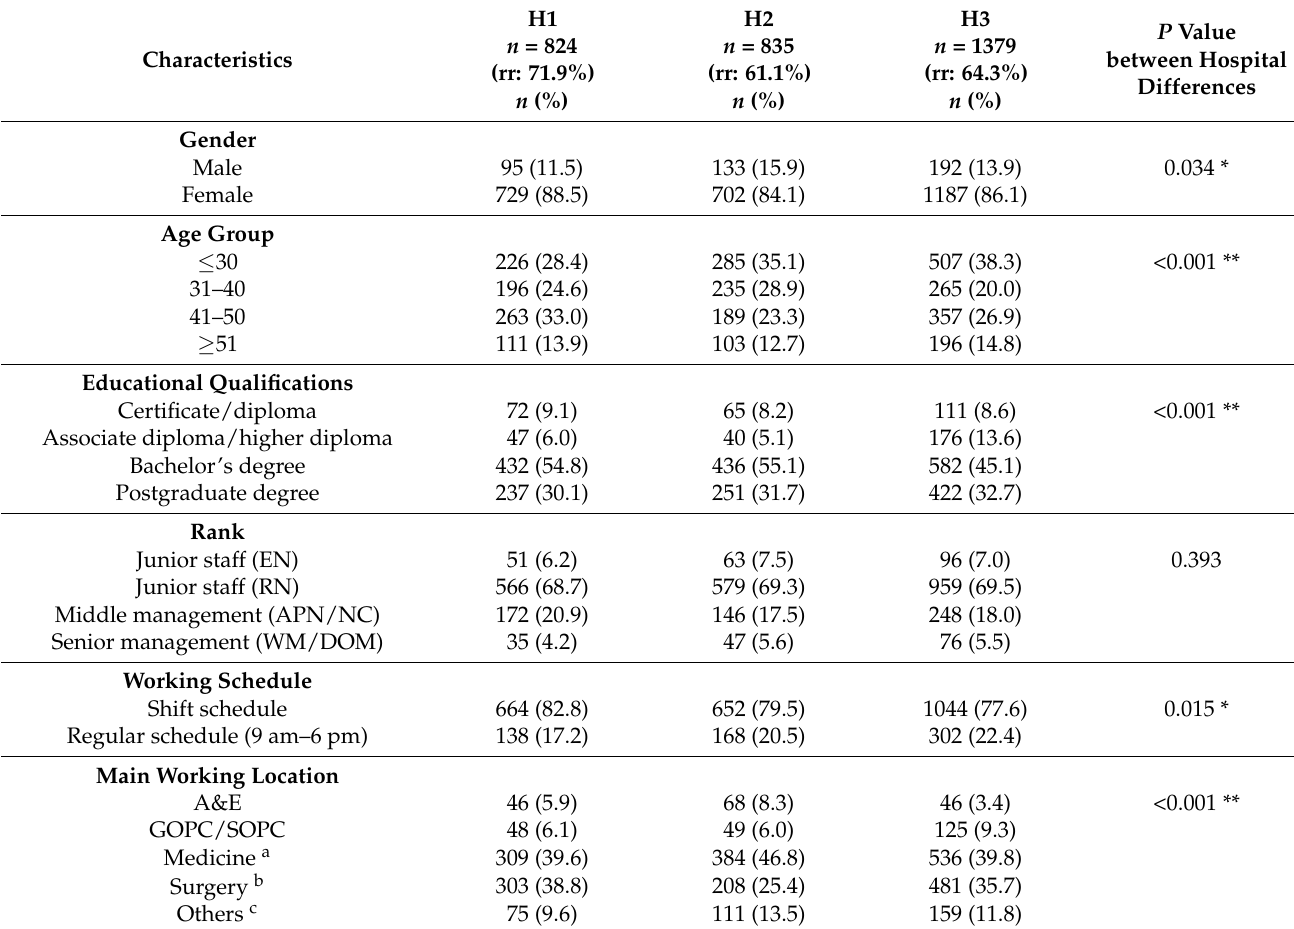
Table 2. Nurse characteristics by